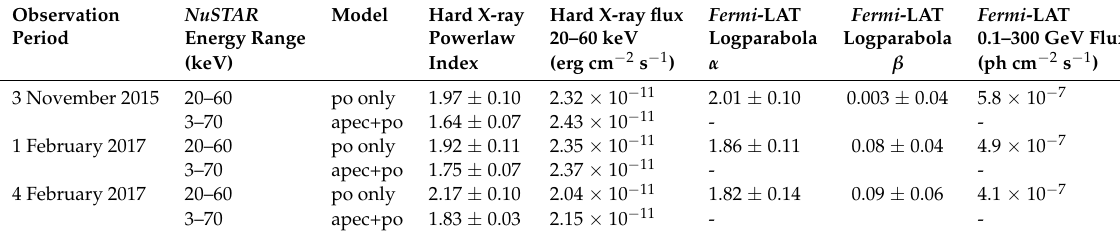
Table 4. Hard X-ray and gamma-ray spectral measurements from NuSTAR and Fermi -LAT, respectively. Observation NuSTAR Model Hard X-ray Hard X-ray